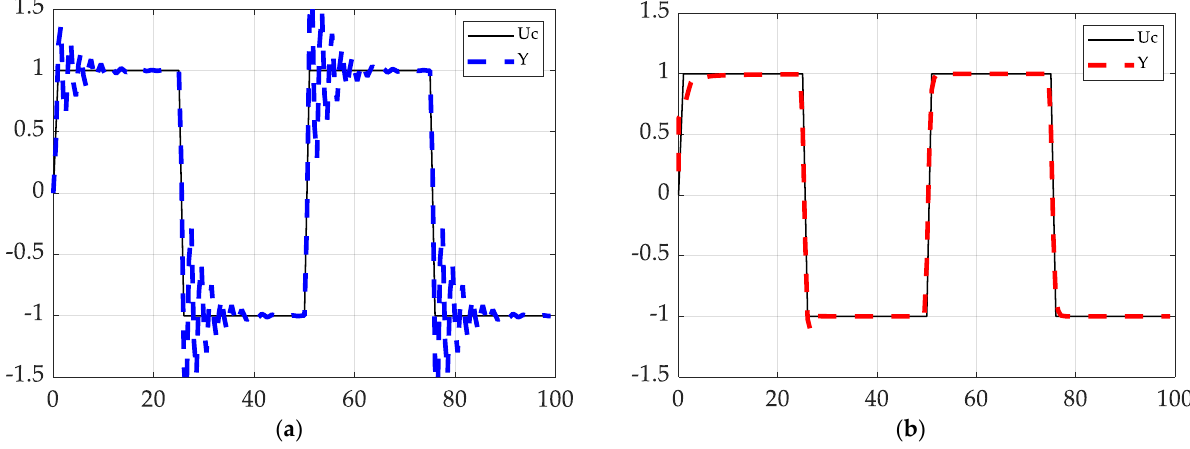
Figure 3. Recently proposed DC motor improvements described in the literature, where the difference is the discretization method and sample time [18]. The command signal is indicated by the black solid line. The output obtained using deterministic artificial intelligence is represented by the blue dotted line in ( a ). The output signal obtained through the model-following method with recursive least squares estimation is described by the red dotted line in ( b ).